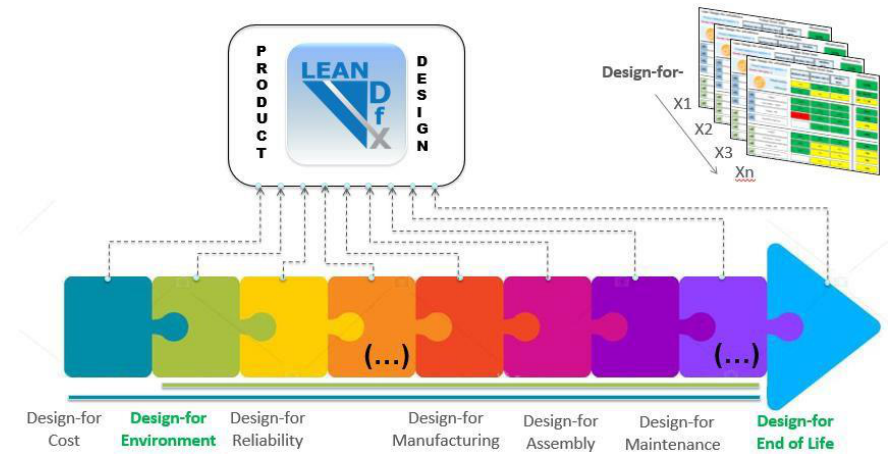
Figure 4. Examples of design domains and their relation within LeanDfX approach [1].